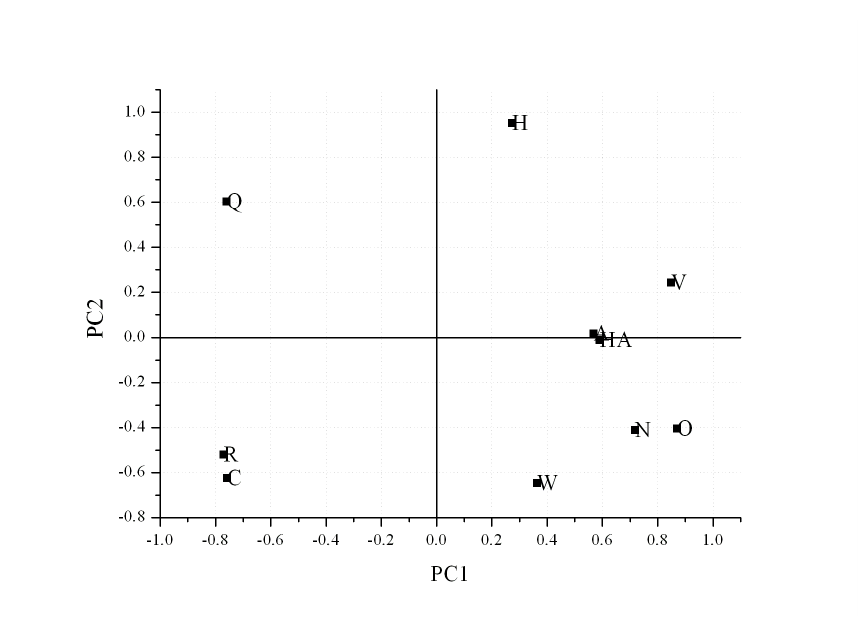
Fig. 2 Principal components weights plot of the geochemical